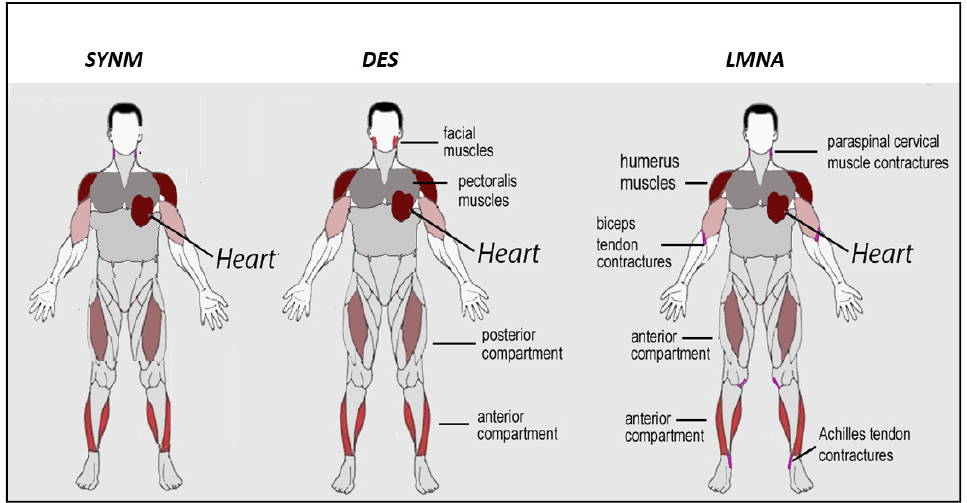
Figure 3. Muscle districts affected in striated muscle disorders caused by mutations in intermediate filament proteins. In the upper row, gene names causative of each group of neuromuscular disorders are indicated ( SYNM , DES , LMNA ). In the case of LMNA -related disorders, sites affected by contractures are also indicated. Achilles tendon contractures may occur, but are infrequent in desminopathy, thus they have not been indicated in the picture.